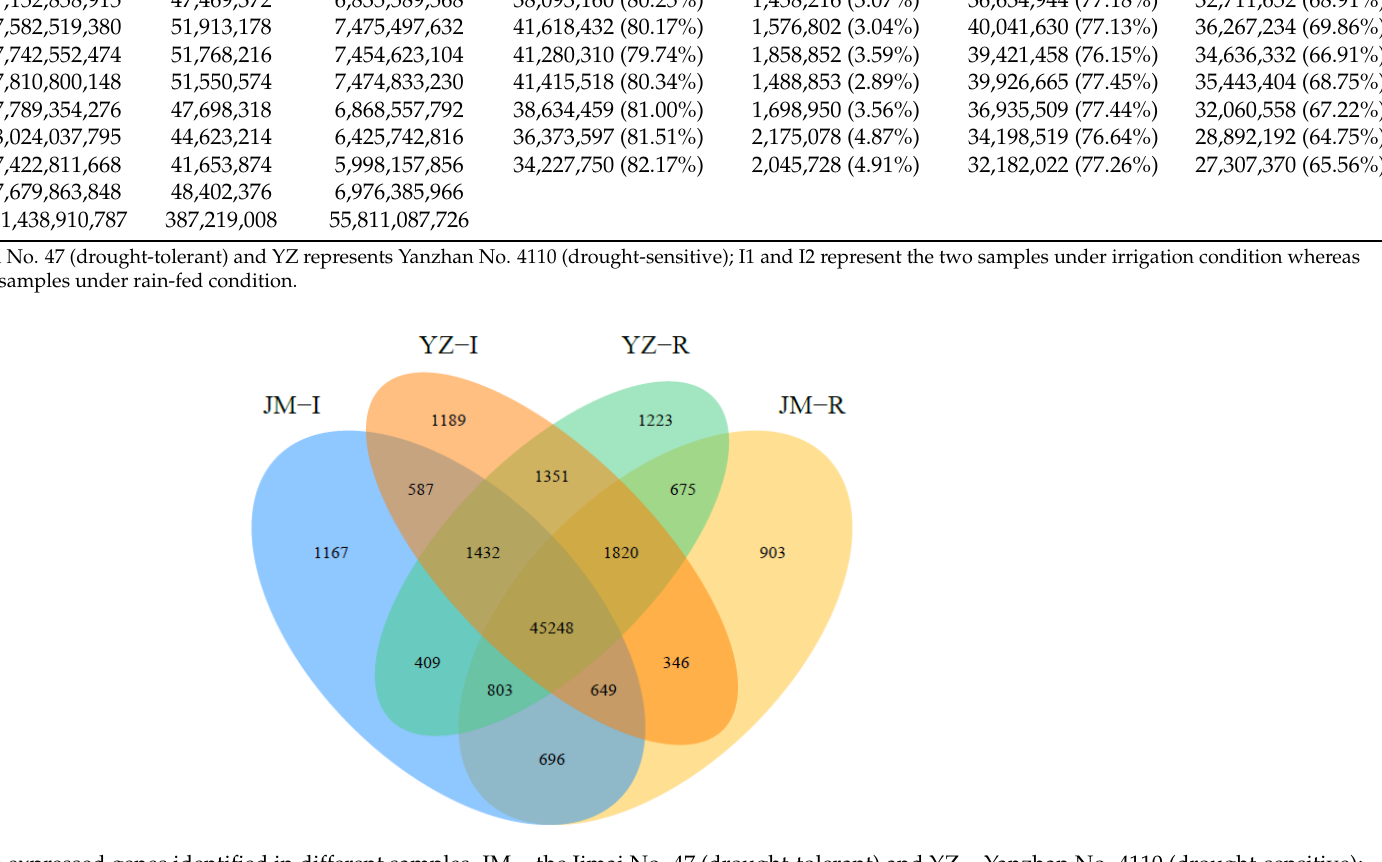
Figure 1. Venn map of the expressed genes identified in different samples. JM = the Jimai No. 47 (drought-tolerant) and YZ = Yanzhan No. 4110 (drought-sensitive); I = irrigation; R = rain-fed (drought).